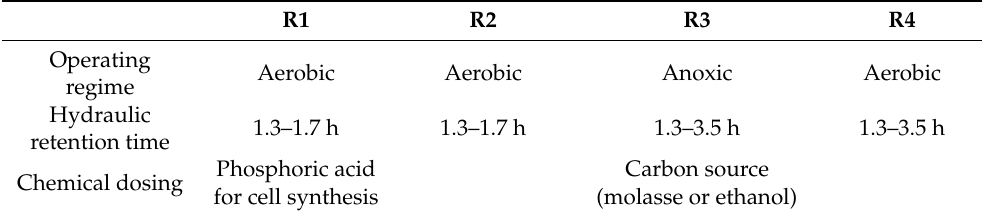
Table 2. Operating conditions in the pilot plant.